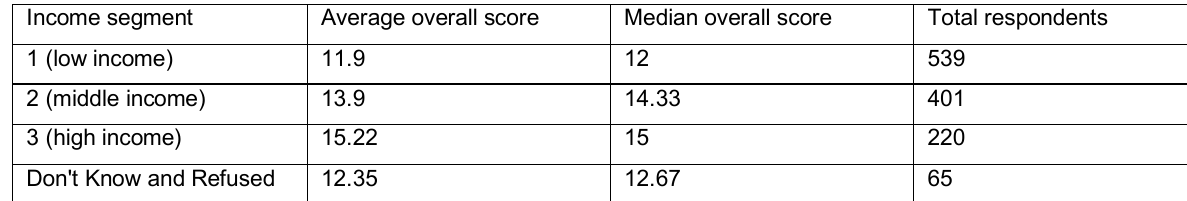
Table 8: Overall Financial Literacy Scores by